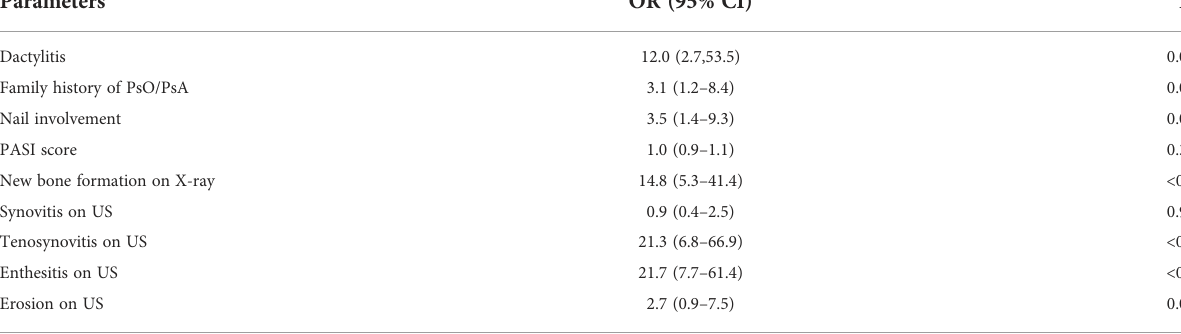
TABLE 2 The risk factors for predicting PsA by multivariate logistic regression analysis.